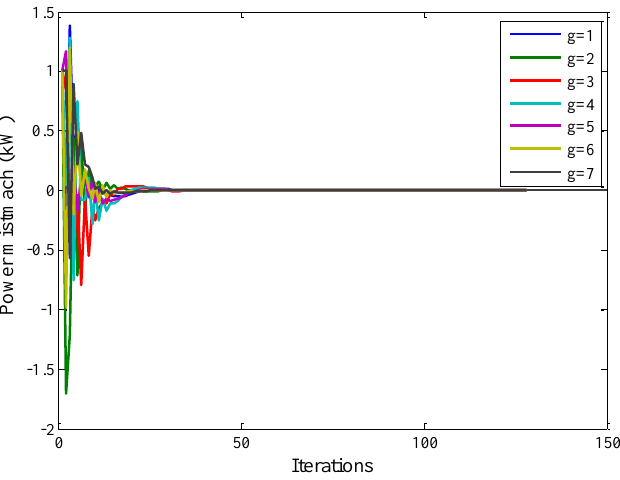
Figure 17. Evolution of power mismatch.